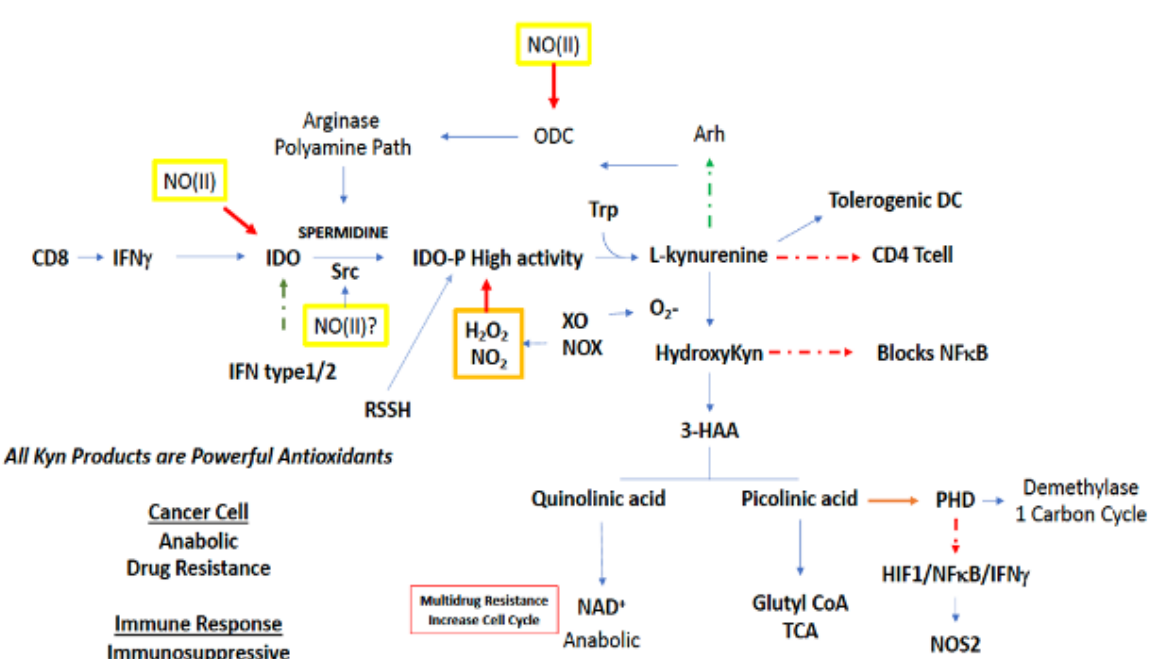
Figure 6. NO reactivity leading to regulation of tryptophan related metabolic pathways. Green boxes/(II) represent intermediate levels of NO (nitrosative signaling) and red boxes/(III) indicate high levels of NO (nitrosative stress) required for NO interaction at the indicated site. Red arrows indicate inhibition, green arrows indicate activation, and broken arrows designate major pathways.